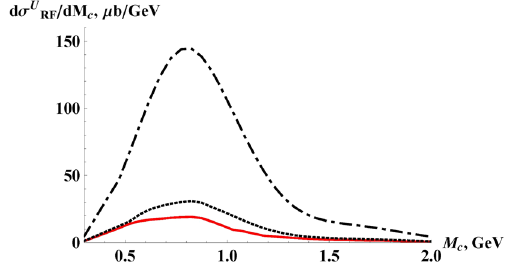
Fig. 13 RF case of the model (see Fig. 3) with all rescattering correc- tions.Thedataontheprocess p + ¯ p → p + π + + π − + ¯ p at | y π | < 2, p > 0 . 2 GeV, (CMS collaboration [21,22]). Curves from T ,π up to down correspond to different values of the parameter Λ π in the off-shell pion form factor (11): Λ π = 4 , 3 , 1 . 6 , 1 . 2 GeV